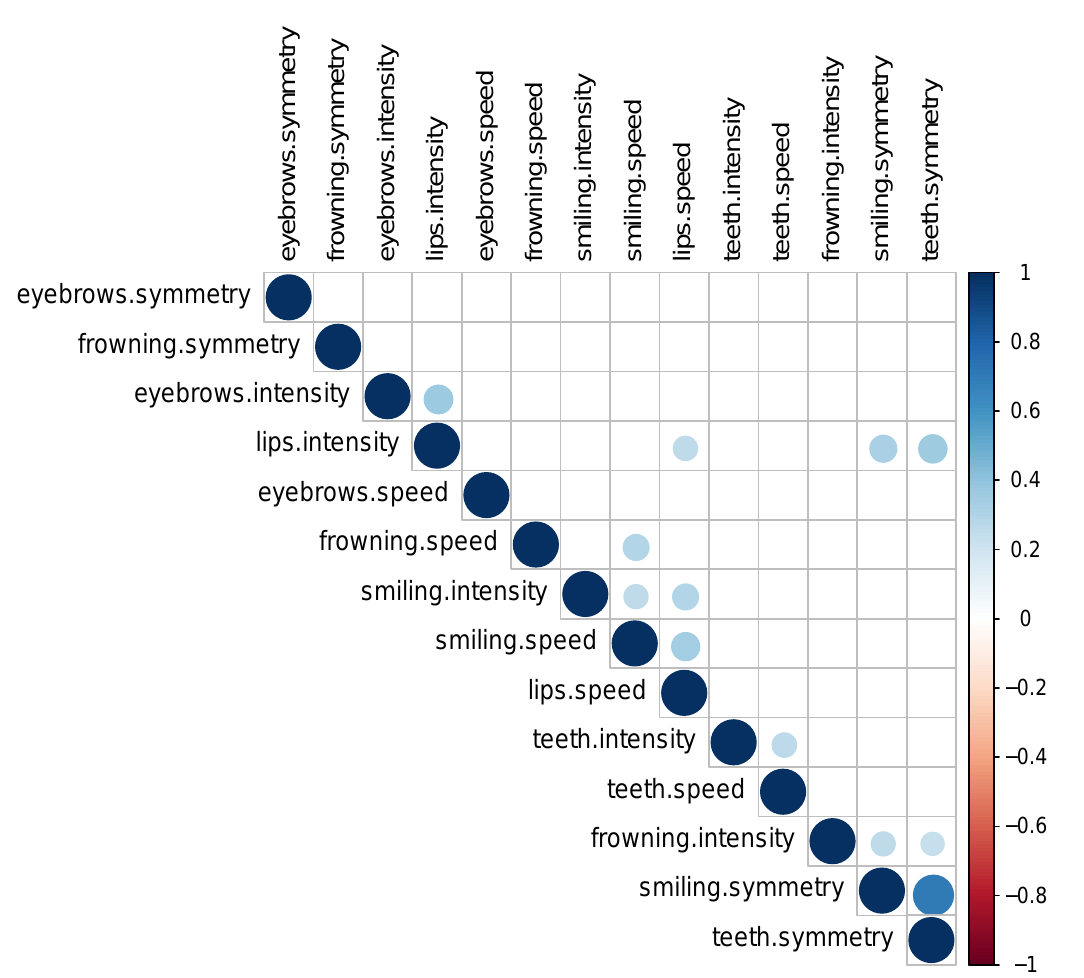
Figure 8. Pearson’s correlogram of health scores for individual